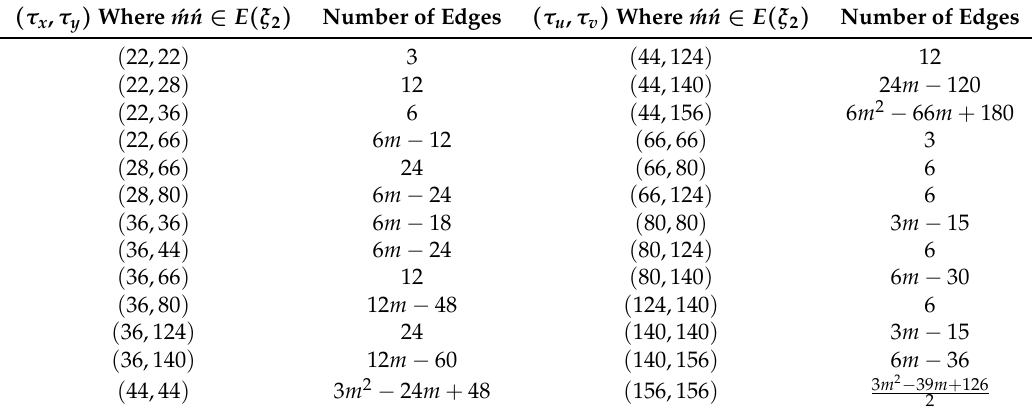
Table 4. Edge partition of the third type of triangular hex-derived network THDN 3 ( m ) based on the sum of degrees of end vertices of each edge.